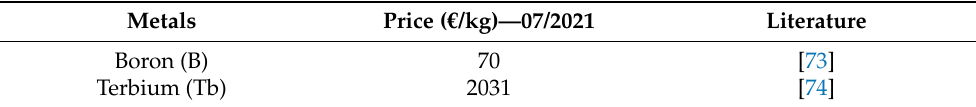
Table 7. Price of metals found in